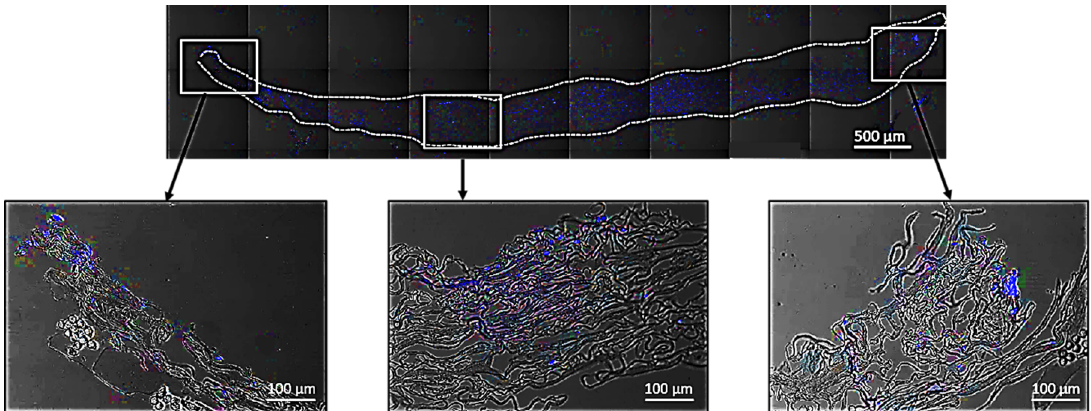
Figure 3. Top image shows an example of tiled-scanned confocal microphotograph of a 4 µm thick MatriDerm ® section stained with DAPI (blue fluorescence indicative of cell nuclei) used to assess cell infiltration into the scaffolds. The white dashed line indicates the edge of the scaffold. The three micrographs at the bottom show higher magnification images of cells (blue fluorescence) in the scaffold that is visible as a mesh of white/grey fibers.